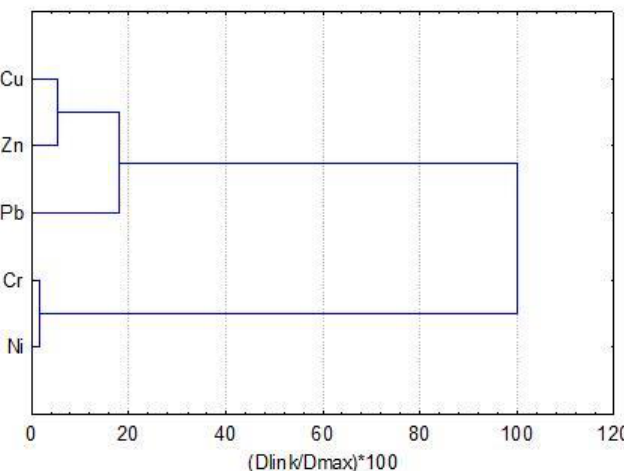
Figure 4. Dendrogram for hierarchical clusters analysis of five metals concentrations in sediments collected from three neighboring gulfs in North Aegean Sea, Greece. Dlink / Dmax represents the quotient of the linkage for a metal divided by the maximum distance; the quotient is multiplied by 100 for standardizing the linkage distance on the y -axis.